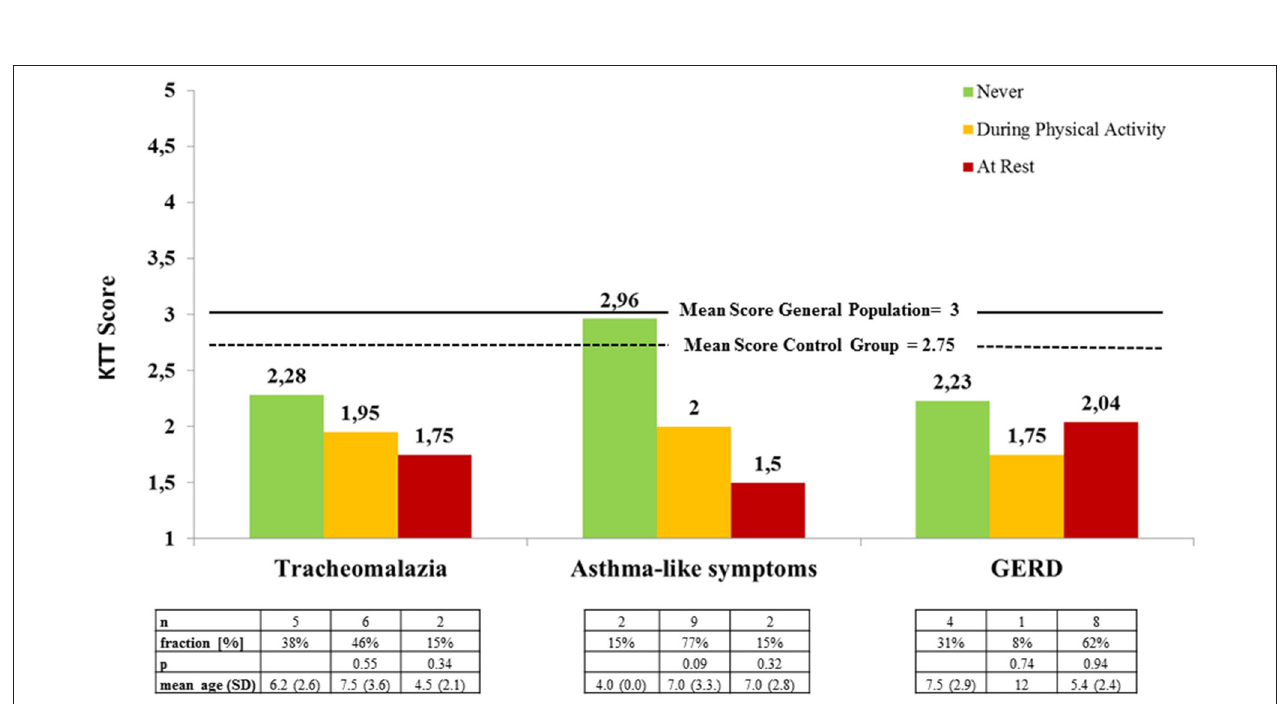
FIGURE 4 | Mean locomotor test results of EA patients according to perceived symptoms during physical activity and at rest ( KTT = Kinderturntest Plus ).